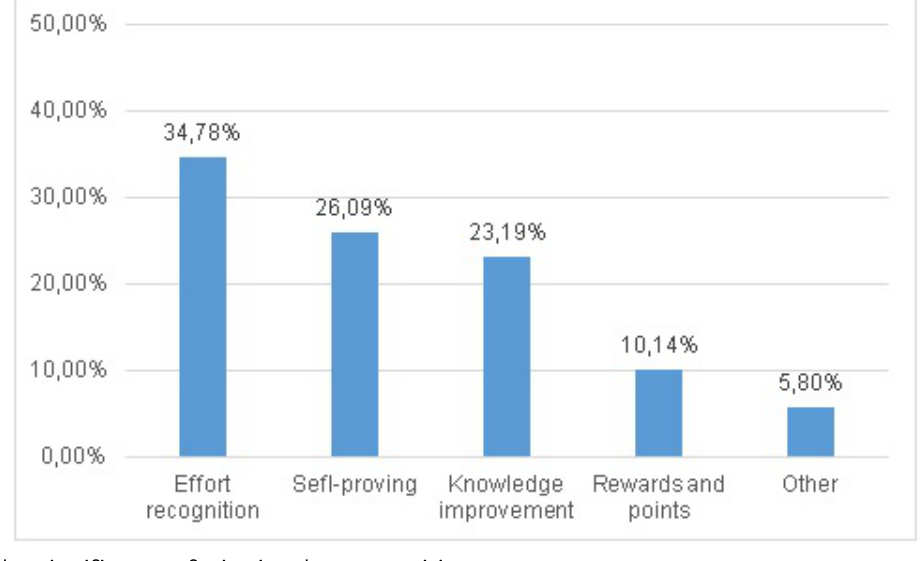
Figure 3. The significance of winning the competition.